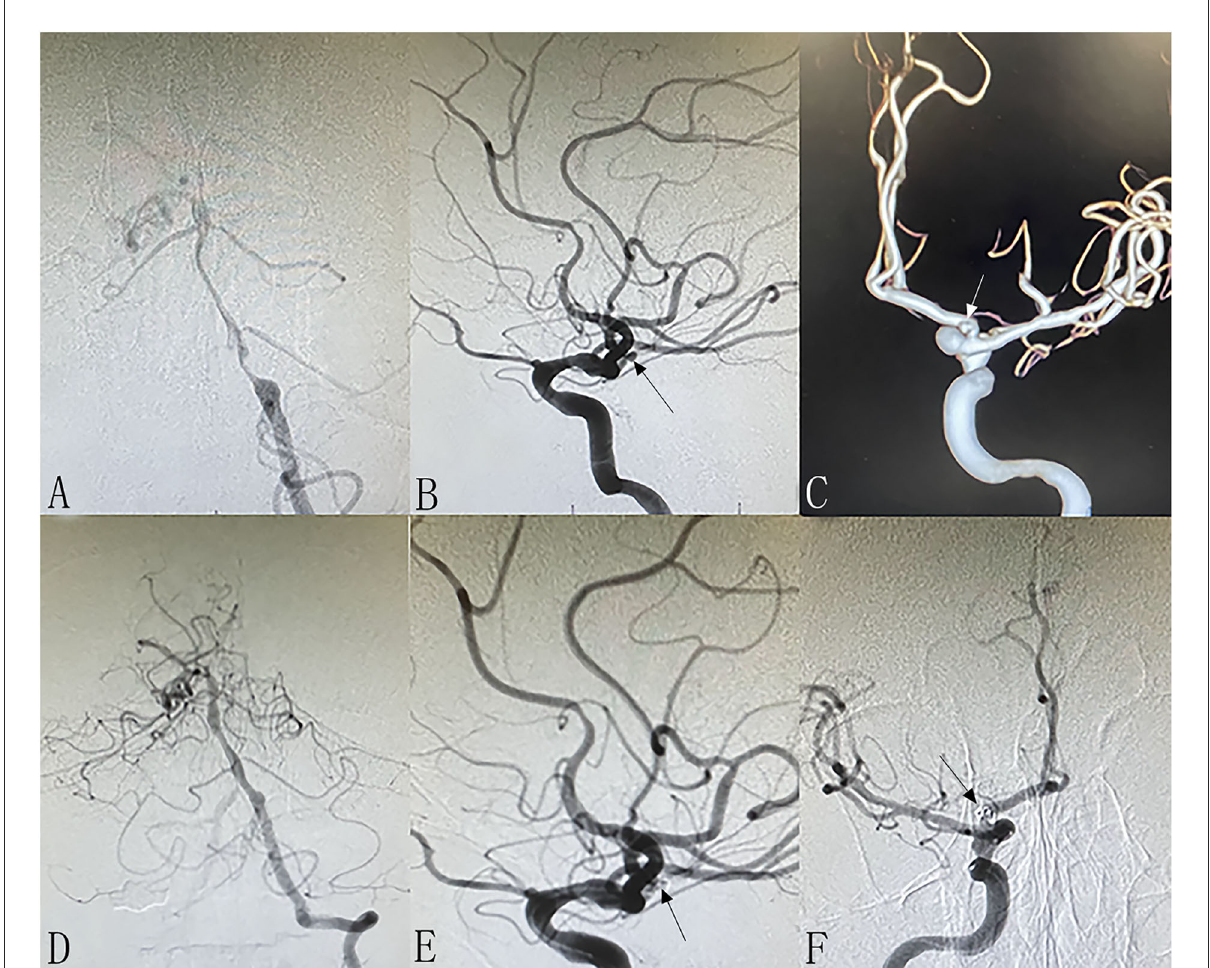
FIGURE2 Patient 13: Separated sessions angioplasty of stenosis and UIA embolization. The patient had vertigo for 2 weeks. DSA showed severe stenosis at left V4 (A) and non-ipsilateral small right anterior artery aneurysm [ (B,C) , arrows]. In the first procedure, we performed balloon dilation and stent implantation for the stenosis (D) . One week later, we performed coiling of the aneurysm successfully (E,F)